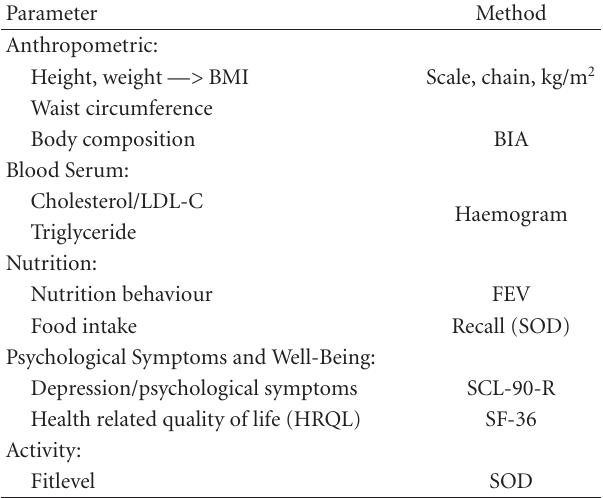
Table 3: Parameters and methods of assessment.